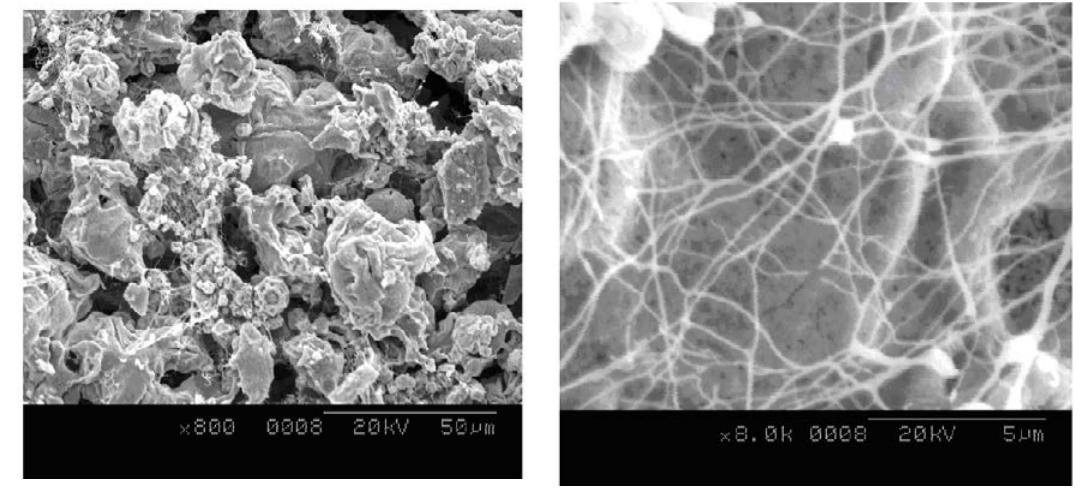
Figure 5. SEM photographs of Ni nanofibers: at low magnification (left), and at high magnification (right).